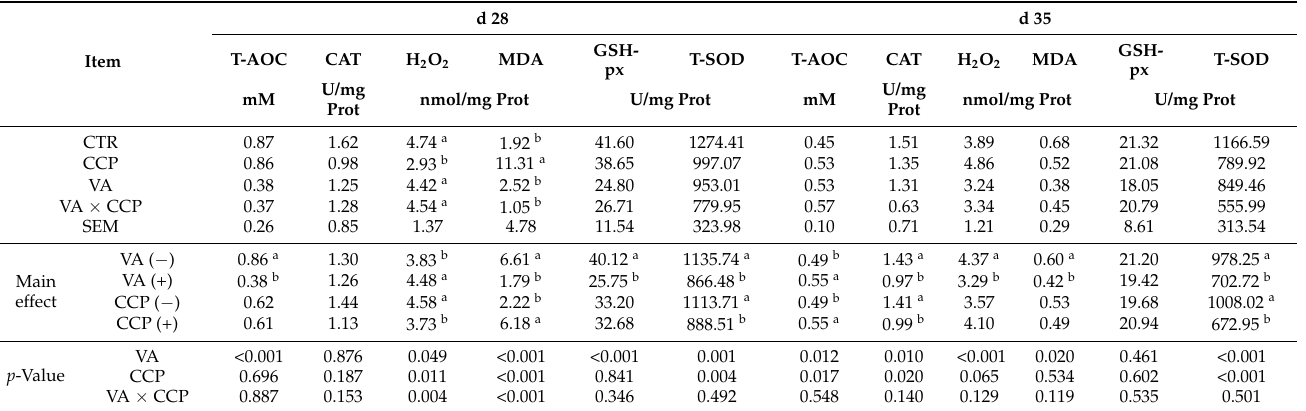
Table 6. Effect of vitamin A on the levels of antioxidant enzymes and peroxidation products in the jejunum of CCP-challenged broilers.